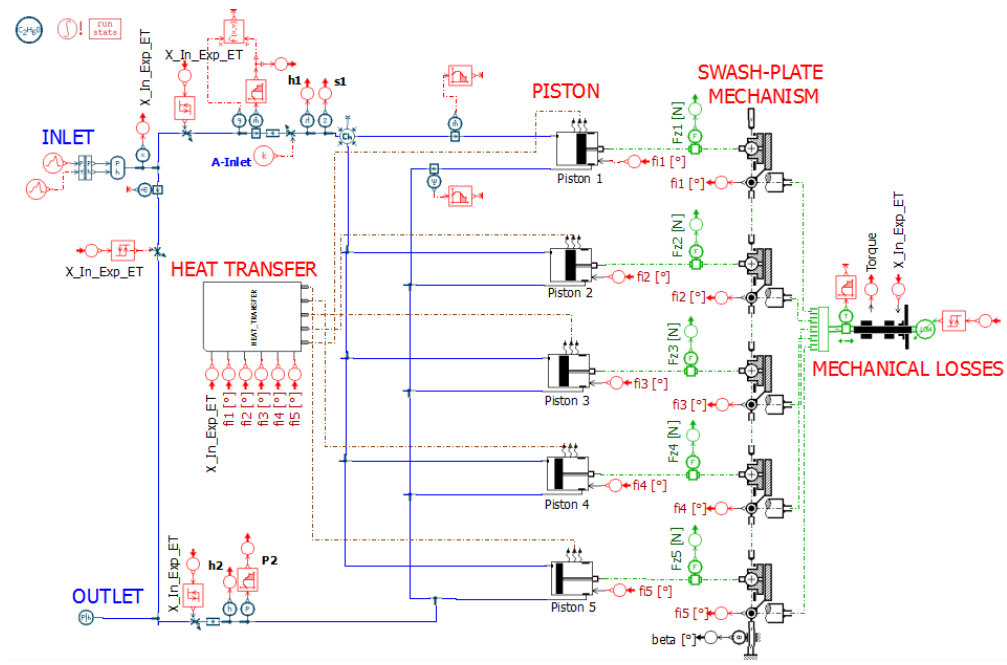
Figure 7. Swash-plate expander model.